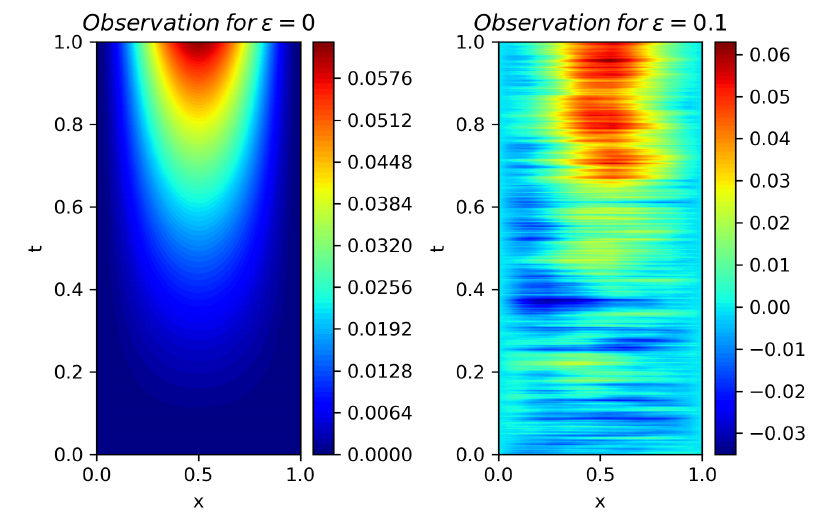
Figure 1. Full observations with ∆ 0 x = ∆ 0 t = 2 − 9 for noise magnitude (cid:101) = 0 ( left panel ) and (cid:101) = 0.1 ( right panel ). The fractional order and diffusion coefficient are fixed to α ∗ = 0.5 and c ∗ = 1.0,